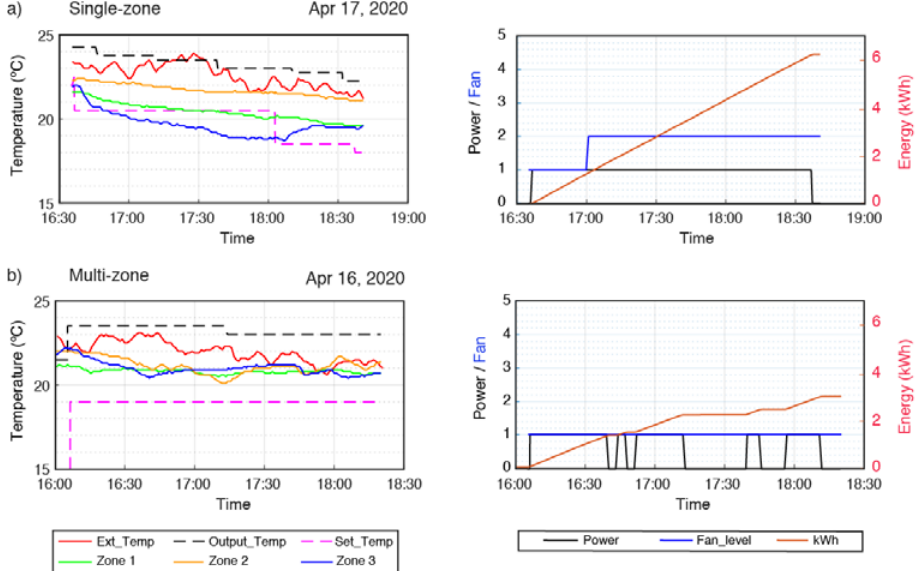
Figure 16. Variation of temperatures and energy consumption. ( a ) Single-zone and ( b ) the proposed multi-zone system.